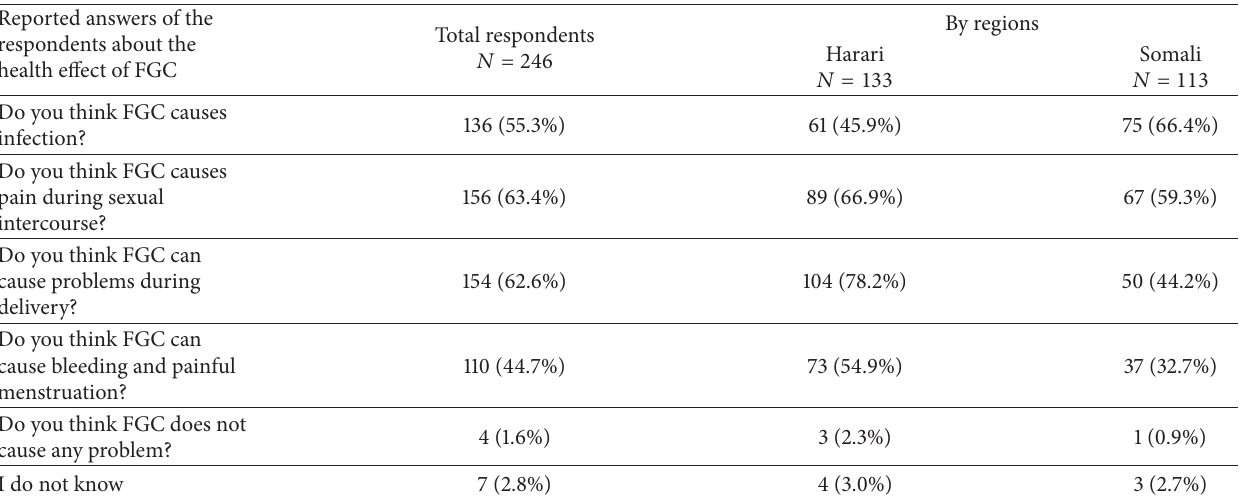
Table 3: Reported health effects of FGC among female respondents in Somali and Harari regions, Eastern